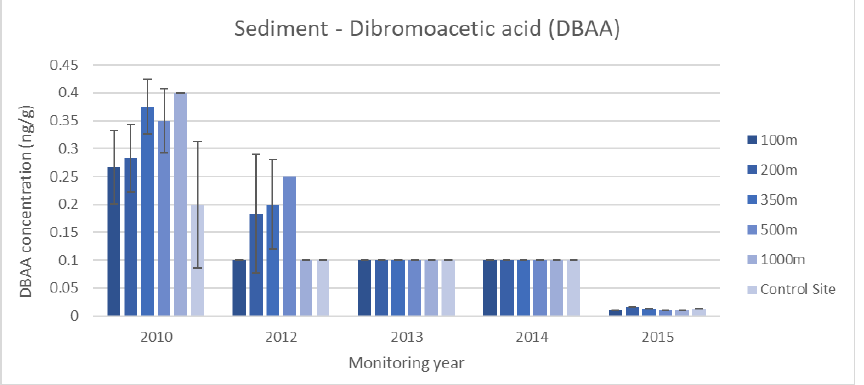
Figure 6. DBAA concentrations in sediment samples (means ± L-levels) collected from 2010 to 2015 at different sites located (100 m; 200 m; 350 m; 500 m; 1000 m) from LNG terminal and at control site in the Northern Adriatic Sea.